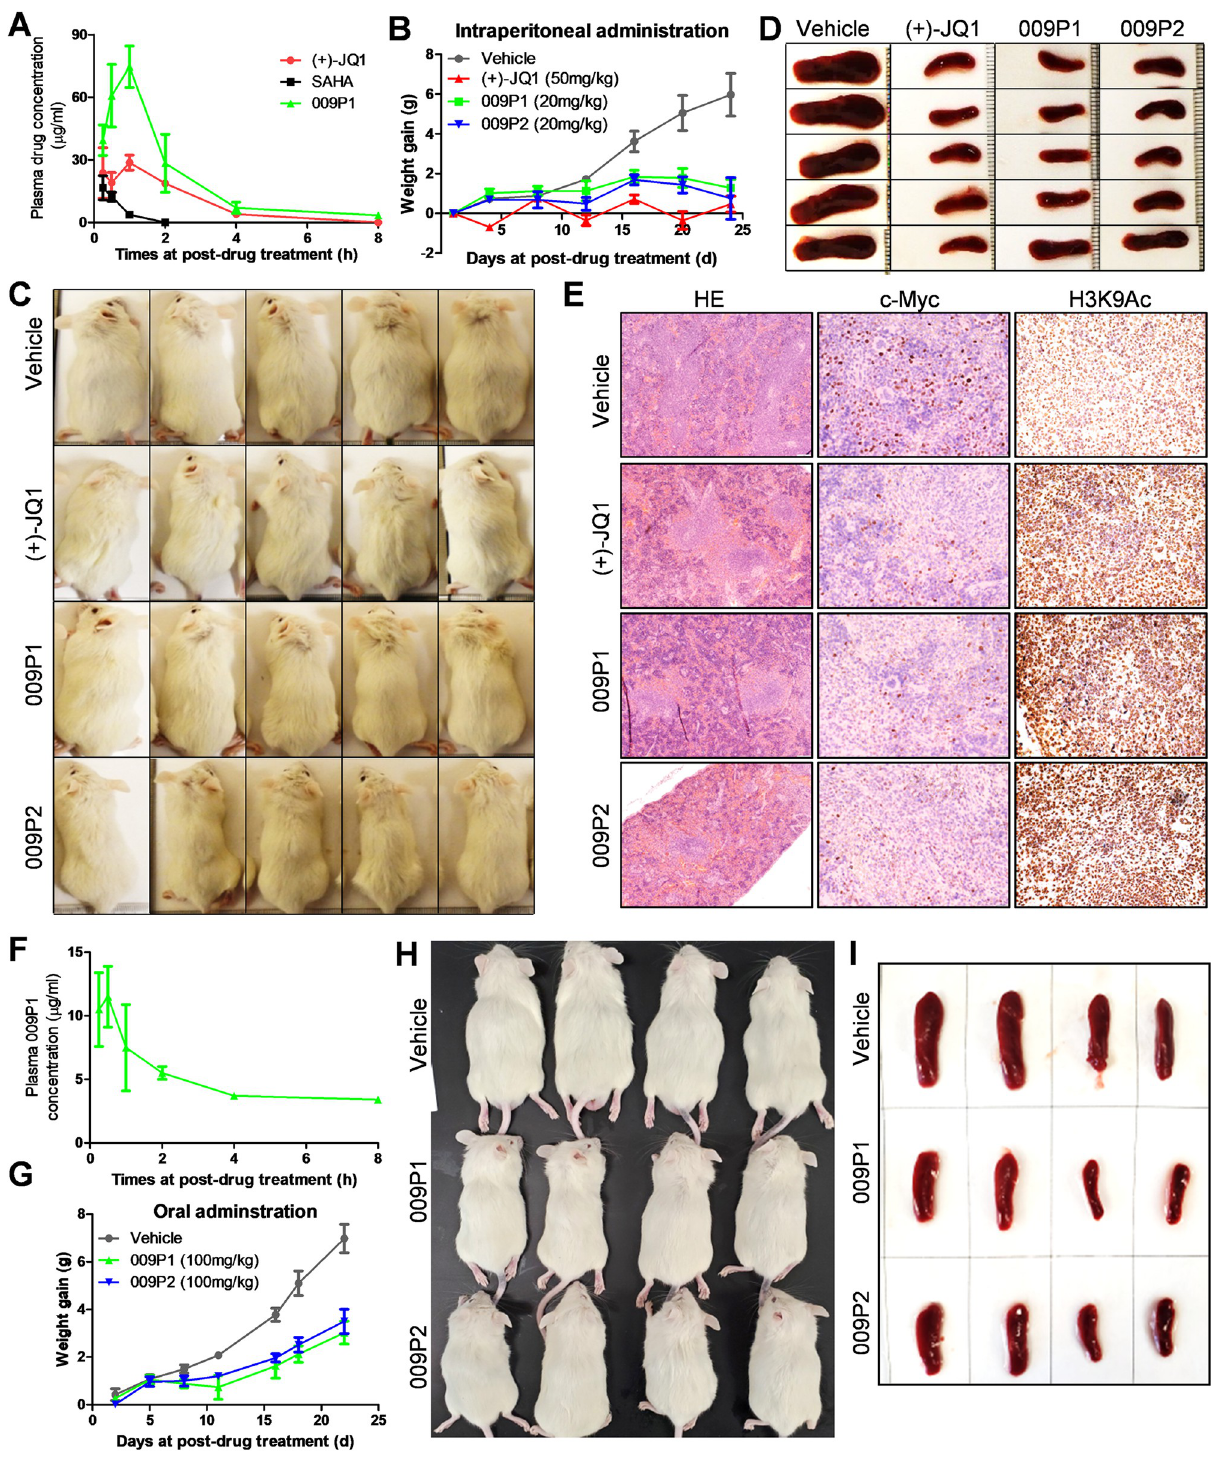
Fig 7. Treatments with 009P1 and 009P2 suppress PEL progression in vivo . ( A ) Plasma concentrations of (+)-JQ1, SAHA, or 009P1 after a single administration of 50 mg per kg body (i.p. injection) were presented as mean ± SD (n = 3 mice per time point). ( B-E ) NOD/SCID mice were injected i.p. with BCBL-1 cells. 72 h later, the compounds or vehicle were administered i.p. as described in the Methods, and weights were recorded weekly. At the end of the treatment period, the splenic tissues were collected from the vehicle or compound treated mice, compared and processed with the H&E and IHC staining. ( F ) Plasma concentrations of 009P1 after a single administration of 50 mg per kg body (oral gavage) were presented as mean ± SD (n = 3